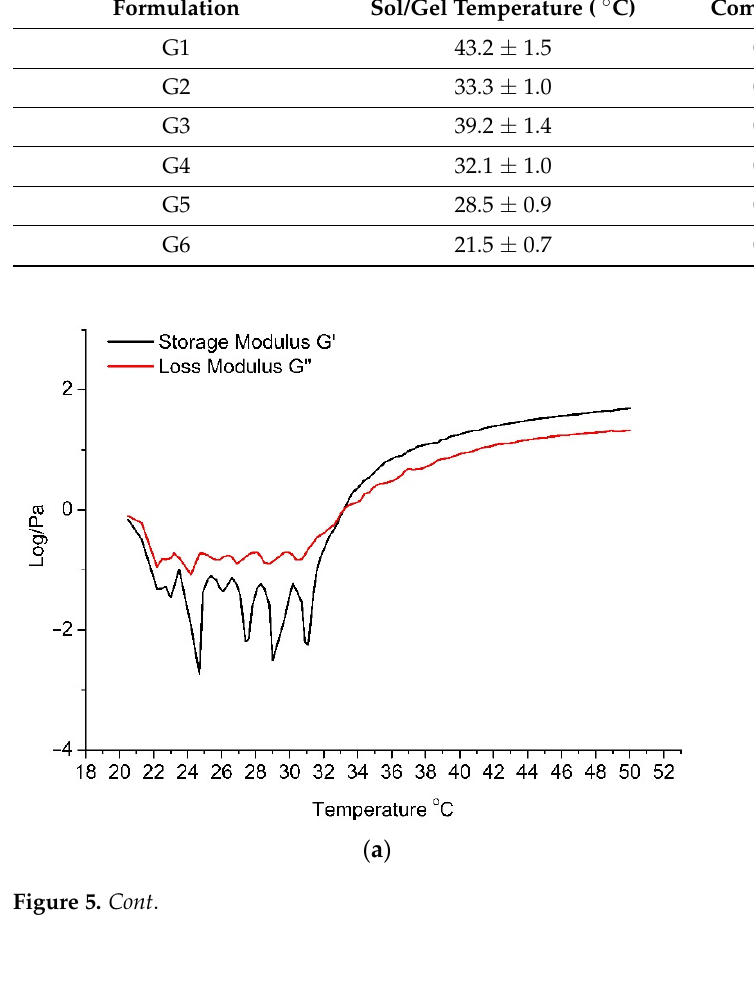
Table 7. Sol-to-gel temperatures of formulations G1–G6 (mean ± SD, n = 3). Table 5. Sol-to-gel temperatures of formulations G1–G6 (mean ± SD, n = 3). Formulation Formulation